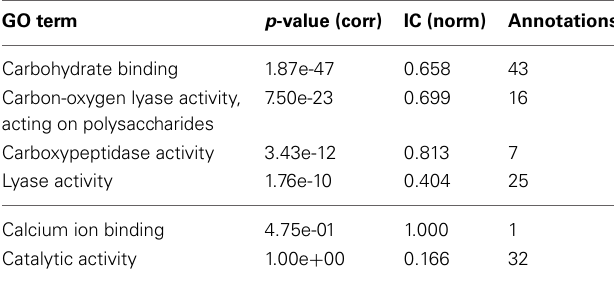
Table 2 | GO term enrichment for CAZy family PL4 with Benjamini-Yekuteli corrected p -values, normalized IC and number of